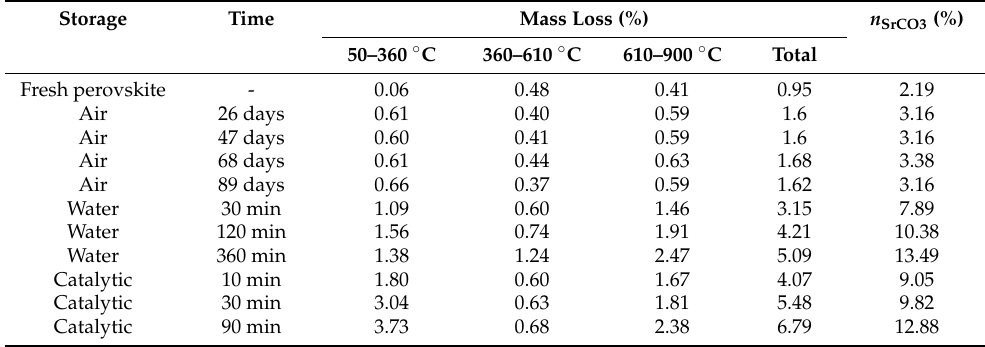
Figure 4. TGA curves showing the mass loss vs. temperature of SCF stored under different conditions. The mass loss is divided into three temperature ranges: 50 – 360 °C (Region I), 360 – 610 °C (Region II), and 610 – 900 °C (Region III). Table 2. Calculated mass losses in different temperature ranges after storage of SCF in air, dispersed in water, and used as catalyst for degradation of bisphenol A. The fraction of blocked Sr-sites n SrCO3 is calculated based on the mass